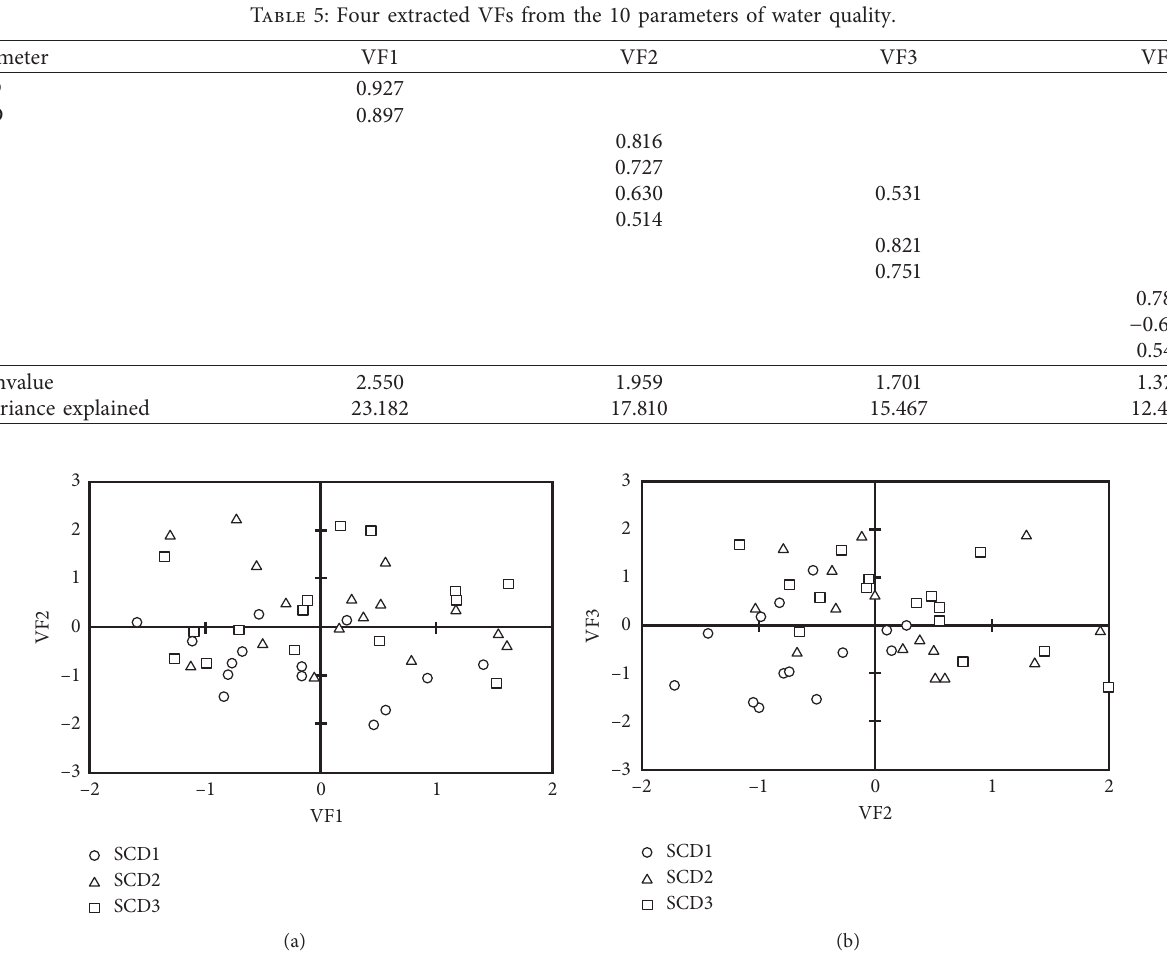
Figure 5: Scatter plot of scores for the four PCs obtained from each monitoring